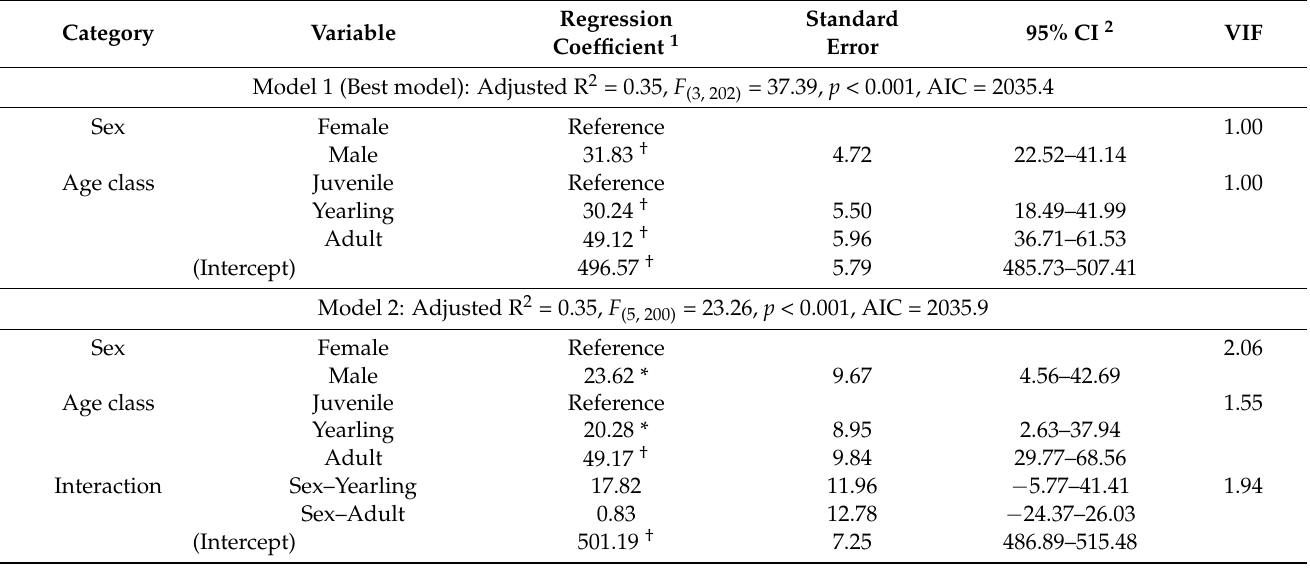
Table 1. Multiple linear regression analysis for body length with region, sex, and age class of feral raccoons in Japan. The best models were selected using the Akaike information criteria (AIC) and valid models within ∆ AIC <